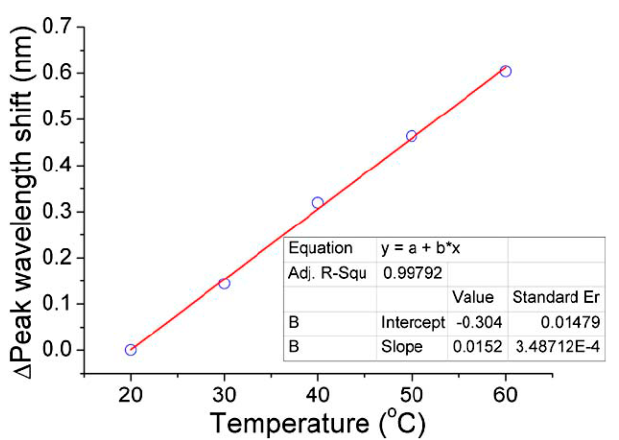
Figure 7. Relationship between the resonance wavelength shift and temperature change. [Reprinted/Adapted] with permission from ref [29], [OSA].